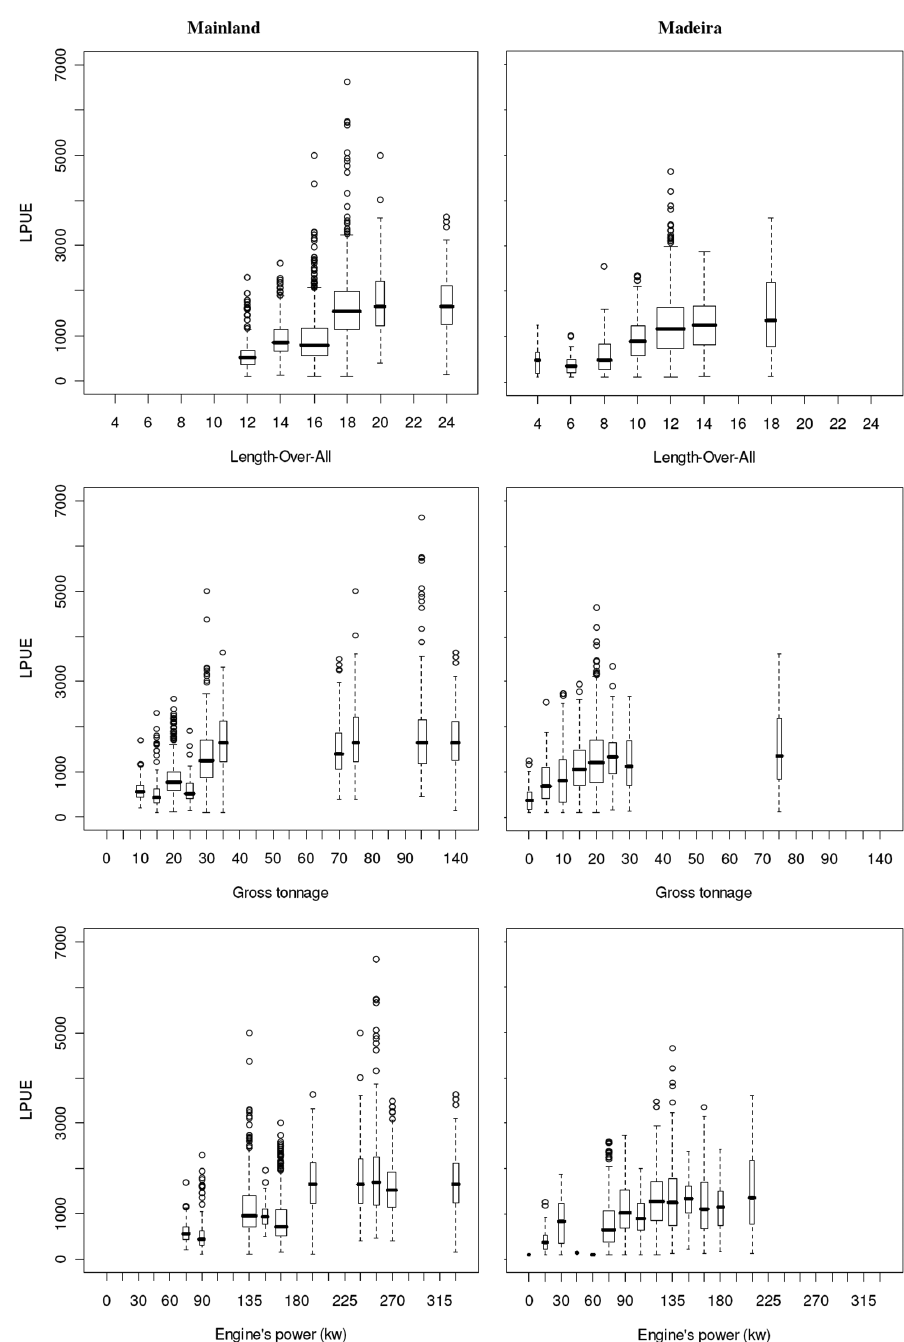
Fig . 2. – Black scabbardfish lPue box-plots by length-over-all, engine’s power and tonnage for vessels from mainland Portugal and Madeira the fishing gear used in the black scabbardfish 4000-5000 (Merret and haedrich, 1997) to an average of fishery in the last few decades is a mid-water horizon- 7000-8000 hooks at present. steel nº 6 hooks are used, tal drifting longline, set in the water column usually at usually baited with salted squid slices ( Ommastrephes depths of 1000 m. Few changes have been recorded in sp.) or filets of horse mackerel ( Trachurus picturatus ) this period, being mainly related to the increase in the and mackerel ( Scomber japonicus ). the fishing opera- number of hooks used in the sets and the fishing strat- tions described by Merret and haedrich (1997) have re- egy. the number of hooks per set has increased from mained almost unchanged to the present time.